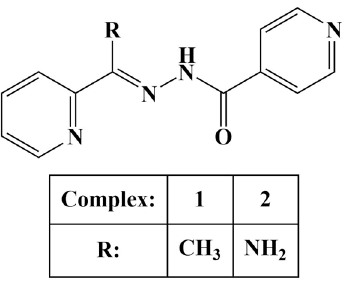
Figure 21. The ligands presented in [92].